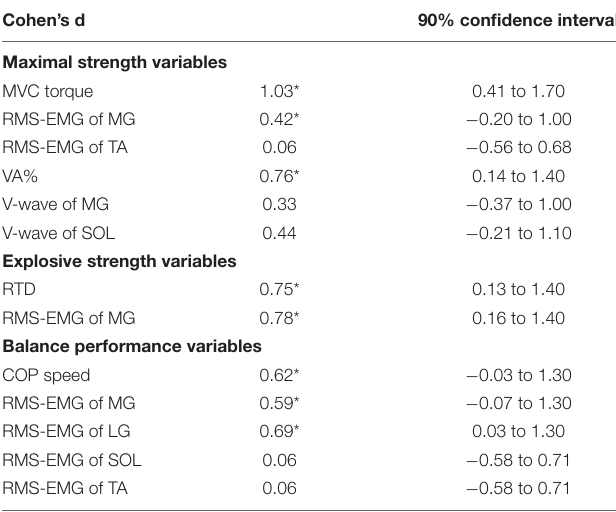
TABLE 2 | Difference in the effect of prolonged vibration between older and young